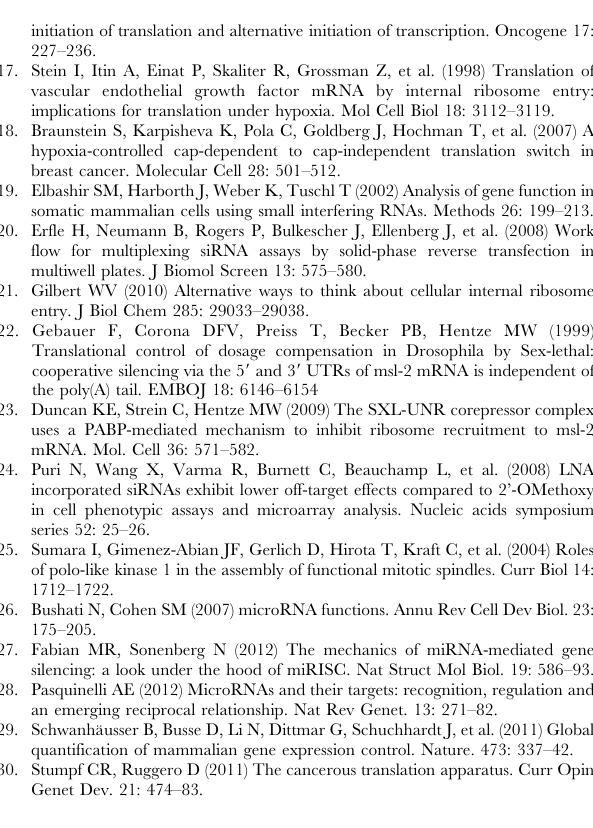
Table S1 Kinase library. Gene symbol, RefSeq, sense- and antisense siRNA sequences and normalized luciferase values for the screened 702 kinases. Table S2 Phosphatase library. Gene symbol, RefSeq, sense- and antisense siRNA sequences and normalized luciferase values for the screened 298 phosphatases. Table S3 Confirmed IRES specific hits. Gene symbol, RefSeq, sense- and antisense siRNA sequences for the 3 IRES specific hits. Table S4 siRNA control sequences. Table S5 Primer sequences used for qRT-PCR experi-